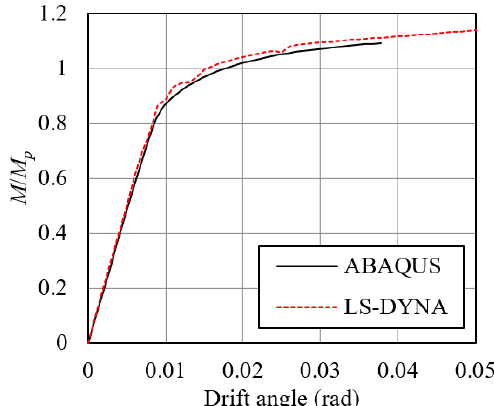
Figure 11. Normalized moment-drift curves generated by two different finite element codes for the proposed column.